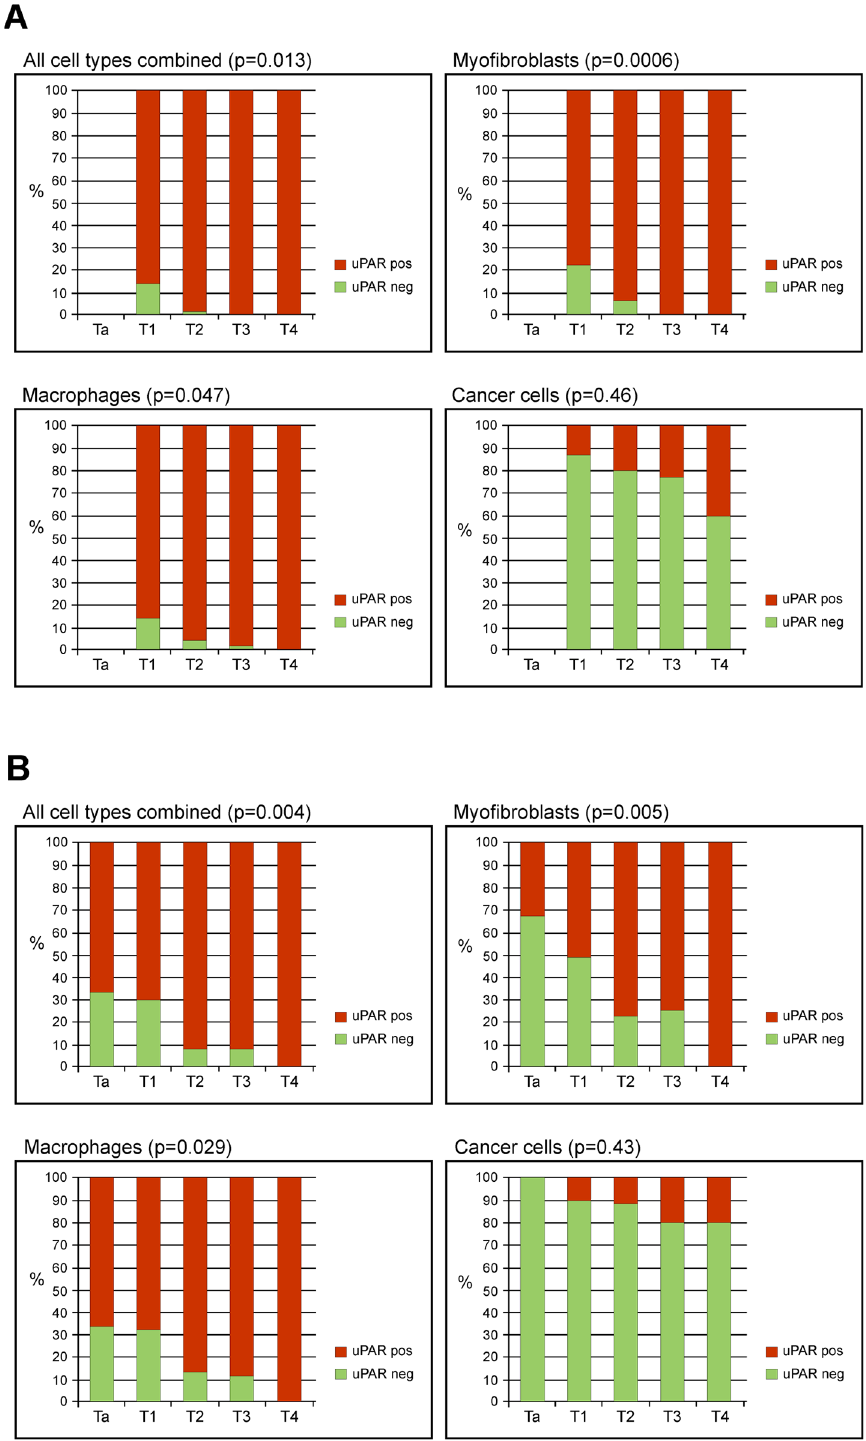
Fig 4. Distribution of uPAR positivity at the invasive front (A) and tumour core (B), respectively. uPAR positivity in both myofibroblasts and macrophages, but not cancer cells, increases significantly with tumour stage. The x-axis shows the tumour stage and the y-axis the percentage of uPAR positive cells. P-values shown are for the χ 2-test.